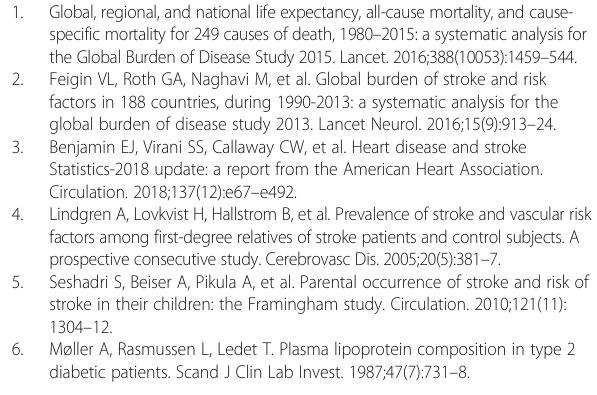
Additional file 1: Table S1. The DE-miRNA of two groups of miRNA dataset. Additional file 2: Fig. S1. The boxplot of miRNA